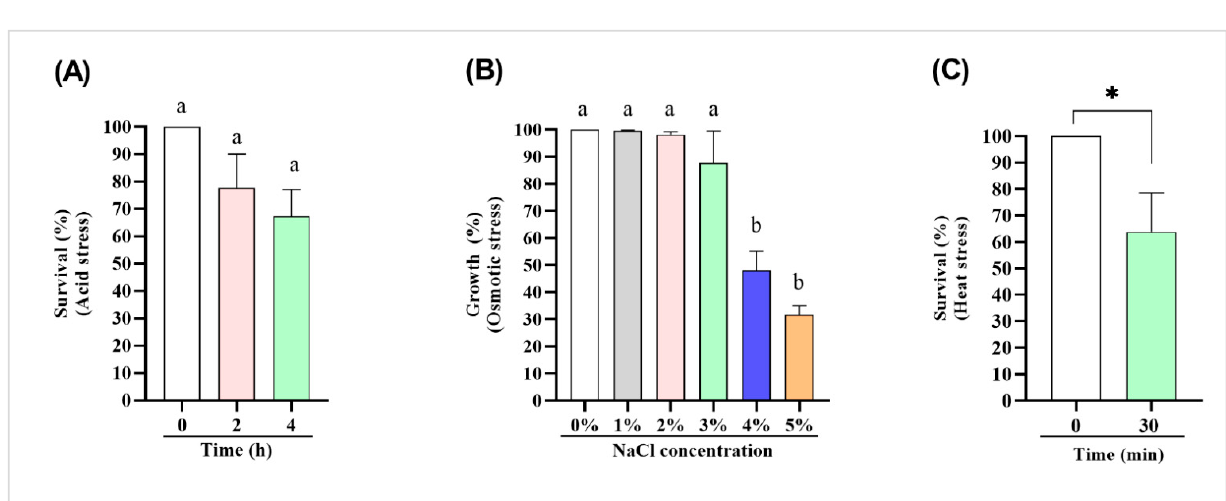
Figure 4. L. delbrueckii CIDCA 133 tolerates different stressors. ( A ) Survival percentage in acid stress (0.3% pepsin solution pH 3.0). ( B ) The growth rate in different concentrations of NaCl (1–5%). ( C ) Survival percentage in heat stress. Different letters and * indicate statistically significant differences ( p < 0.05) by ANOVA followed by Tukey’s post hoc test (acid and osmotic stress) and Student’s t -test (thermal stress).